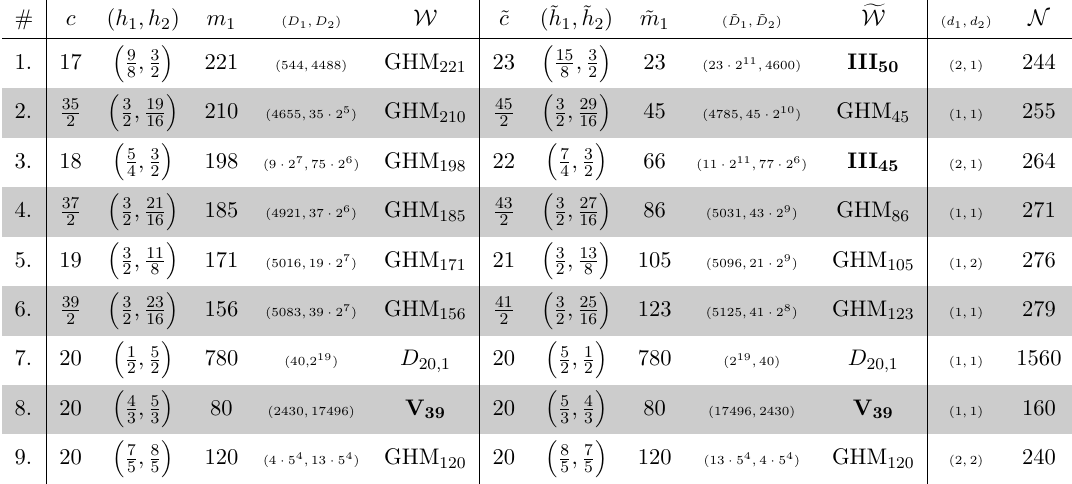
Table 23. CFT pairings, c H = 40 with ( n 1 , n 2 ) = (3 , 3) . H with χ H = j 2 / 3 ( j + N 0 ) where the